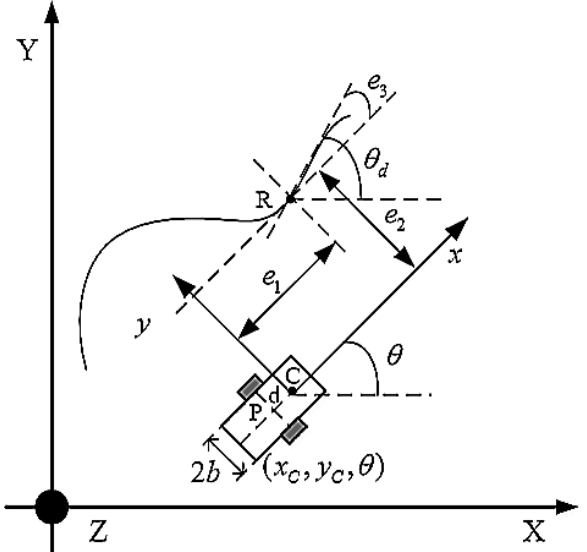
Figure 3. Modeling of wheeled autonomous robot.